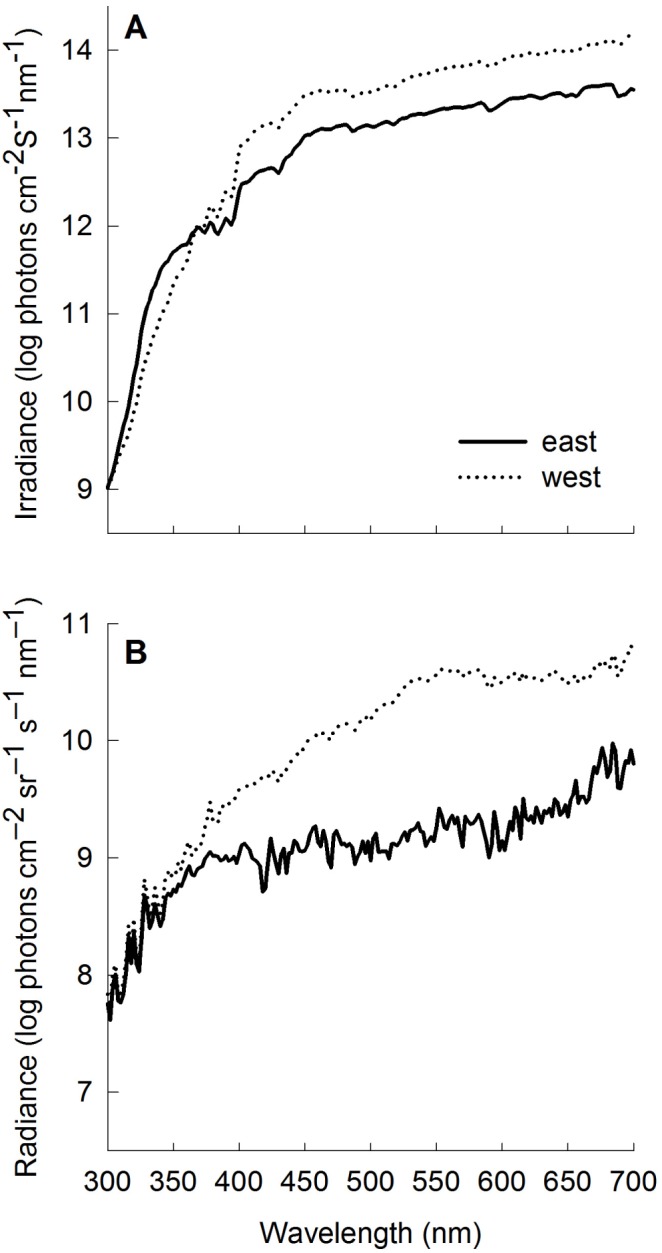
Mean (A) irradiance and (B) radiance spectra characterizing the sampling habitats in the east (solid line) and west (dotted line) populations where P. parae and their predators are found.